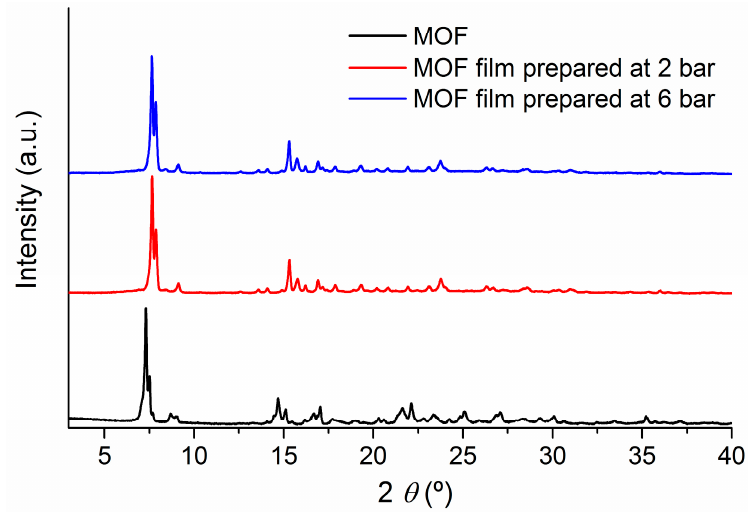
Figure 6. Powder X-ray diffraction patterns of [Zn 2 (bpdc) 2 (bpee)] ( black ) and films prepared by soft-imprinting on cellulose acetate at 2 ( red ) and 6 bar ( blue ).